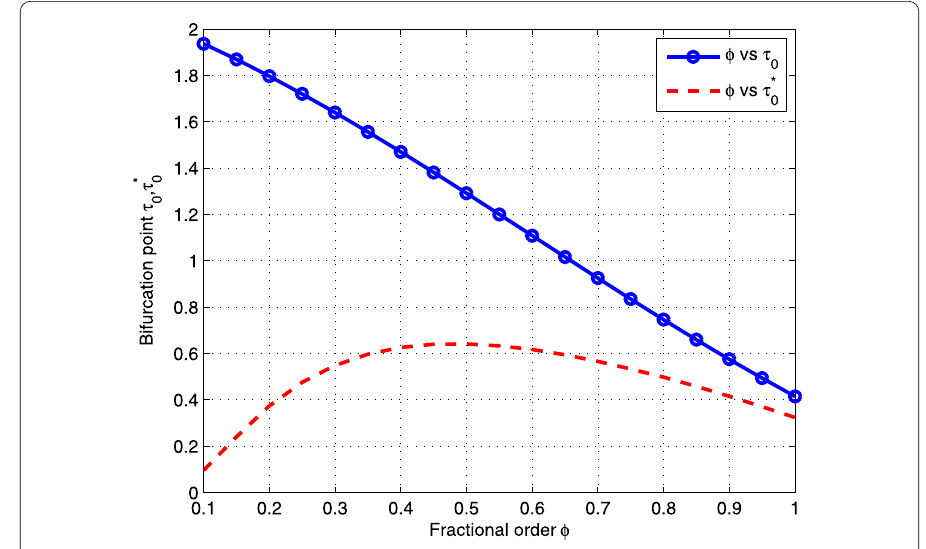
Figure 9 Effects of φ on τ 0 in system (5.1) and τ ∗ 0 in system (5.2)